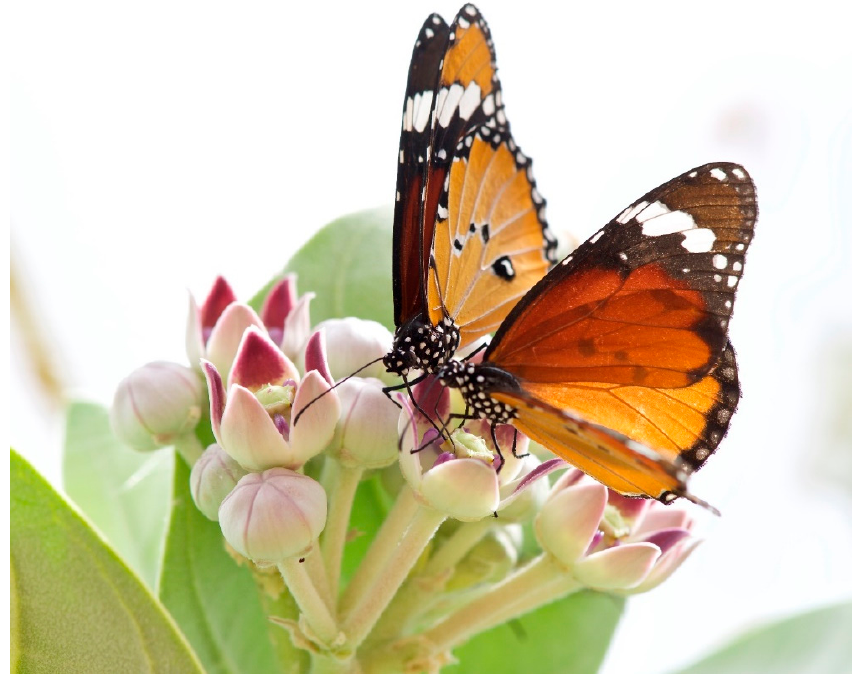
Figure 1. Male (left) and female Queens sharing nectar from a Calotropis procera (Aiton) W.T.Aiton flower on Fuerteventura. Photo, Chris Ward.